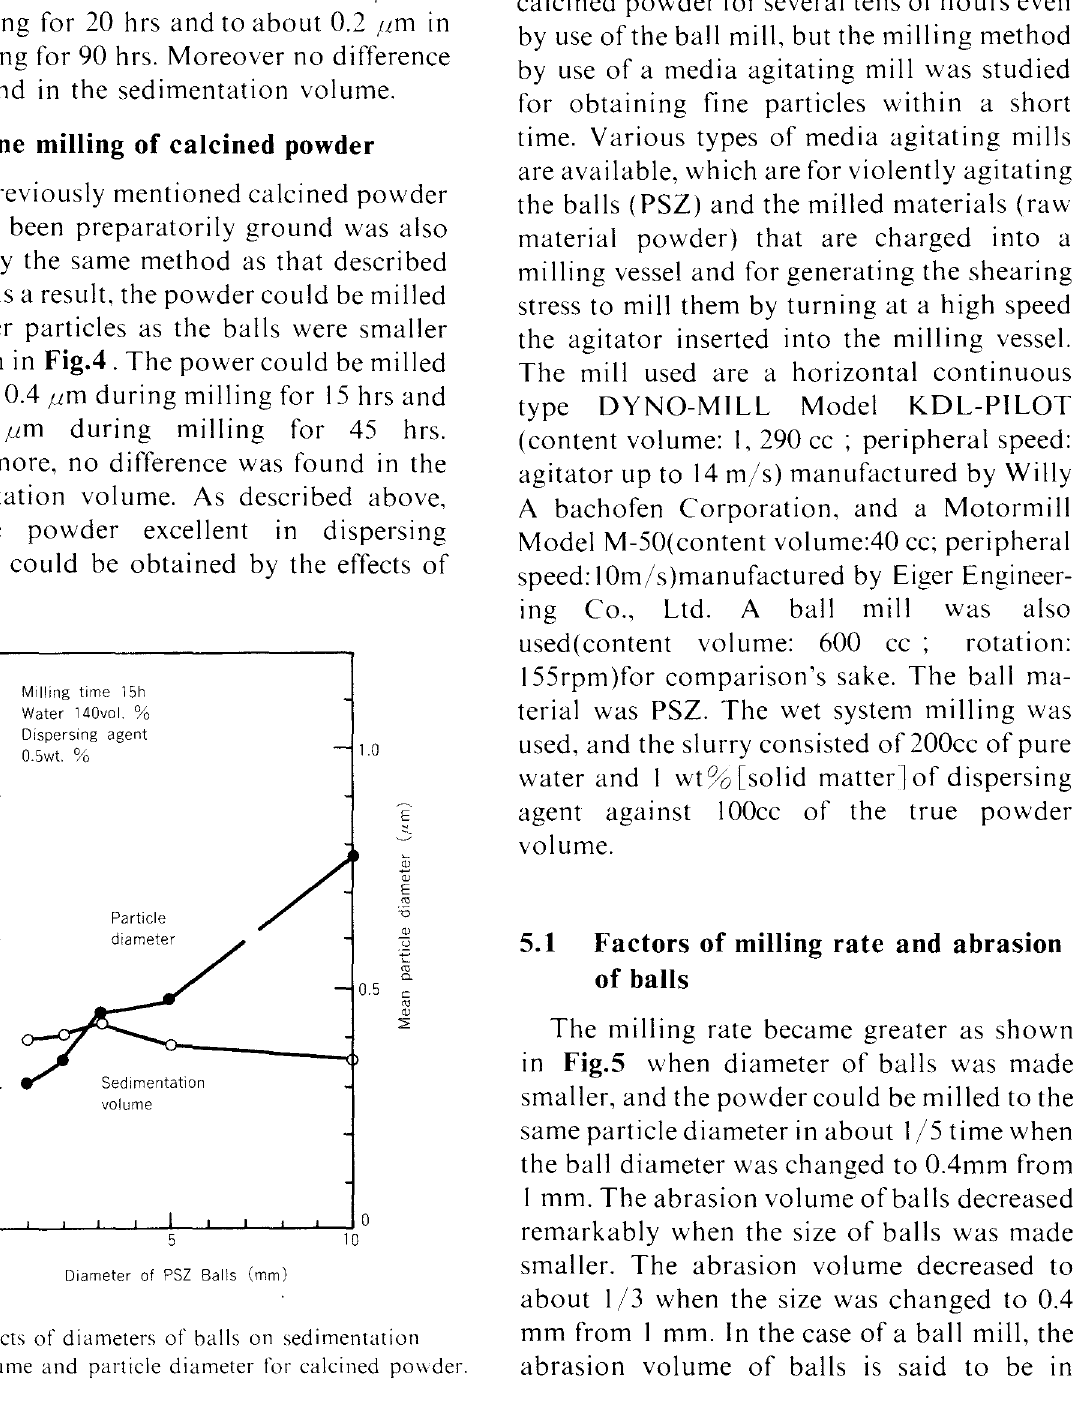
Fig. 4 Effects of diameters of balls on sedimentation volume and particle diameter for calcined